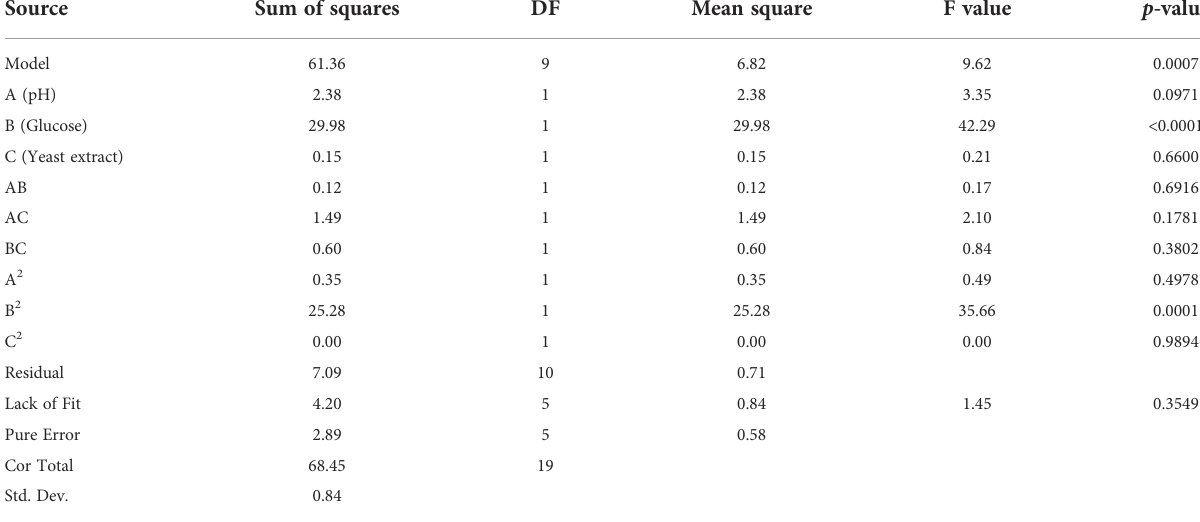
TABLE 3 One-way analysis of variance (ANOVA) of the quadratic model [Eq. (5)].